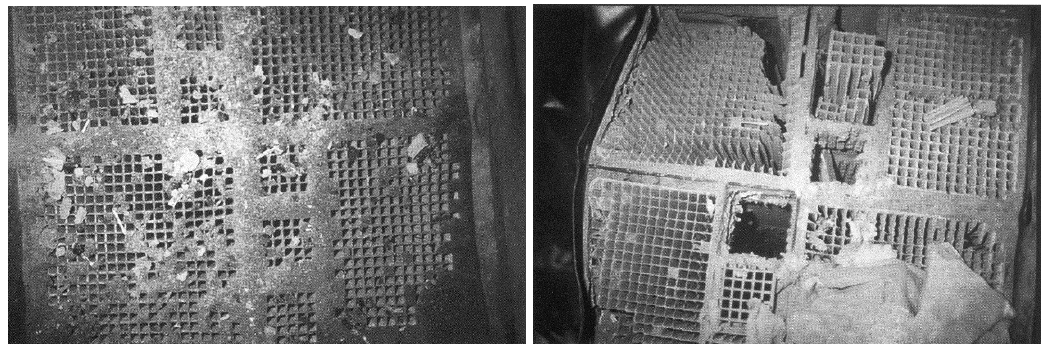
Figure 40. Catalyst channel plugging ( left ) and damage due to erosion ( right ) during operation in an SCR facility. Reproduced from